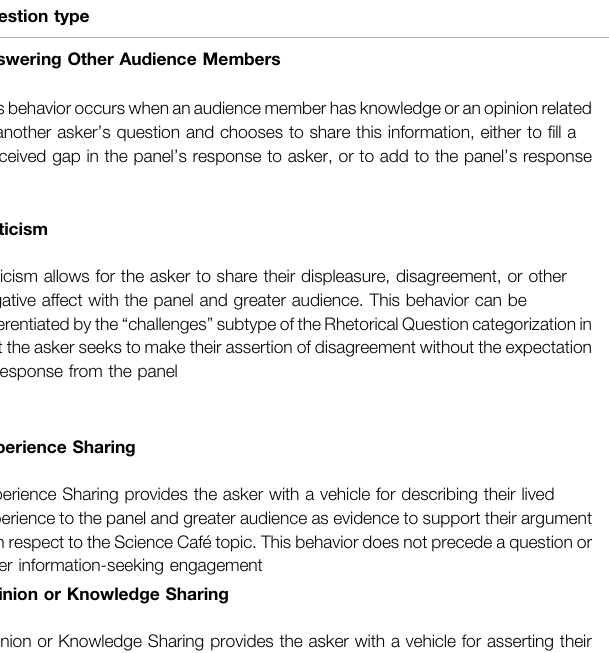
TABLE 4 | Framework layers of non-information – seeking question types and